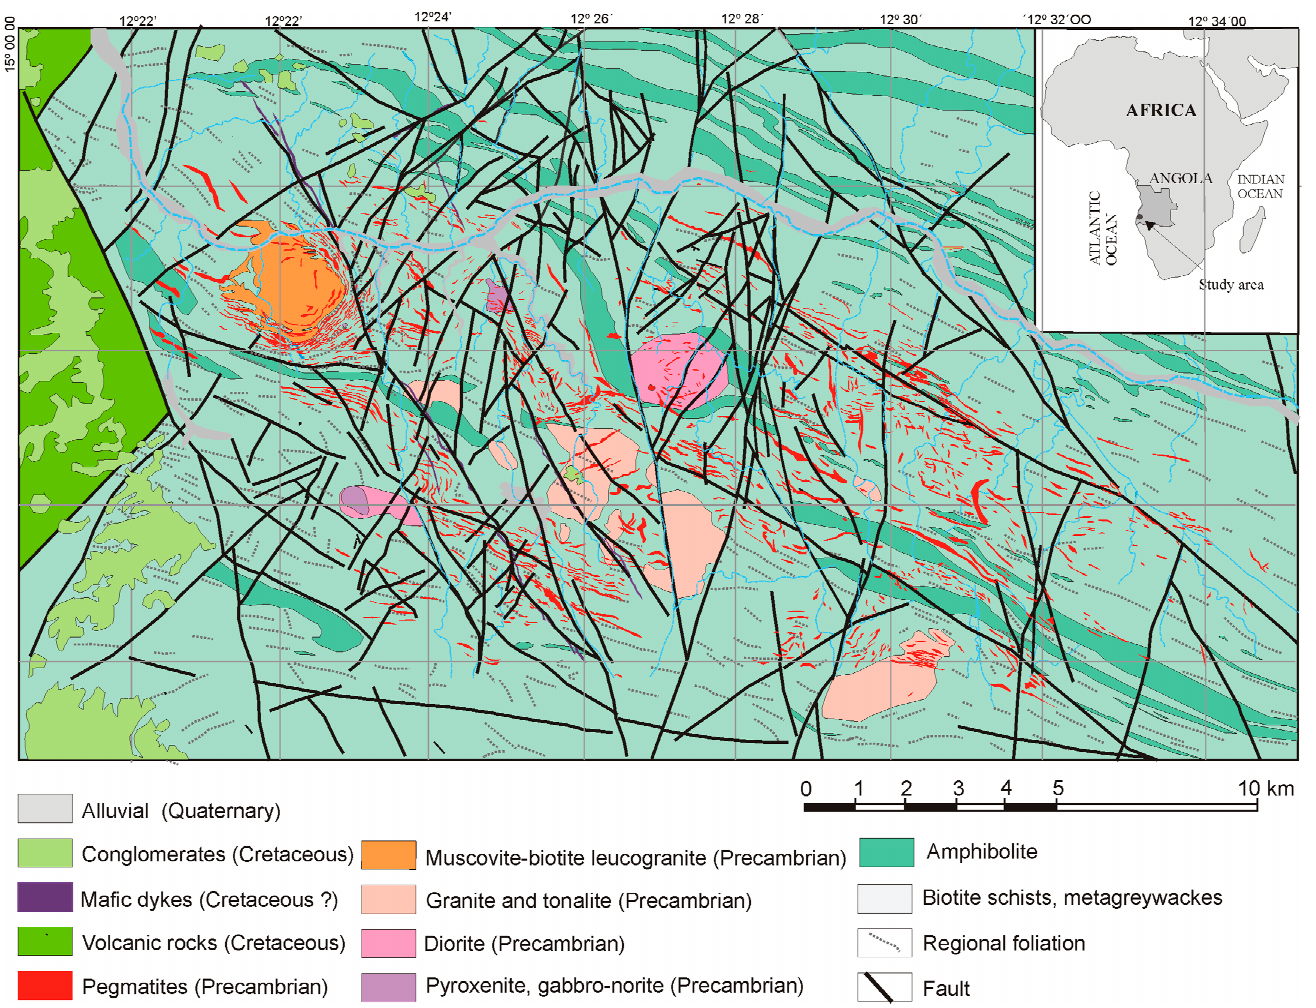
Figure 1. Geological map of the Giraúl pegmatite field.